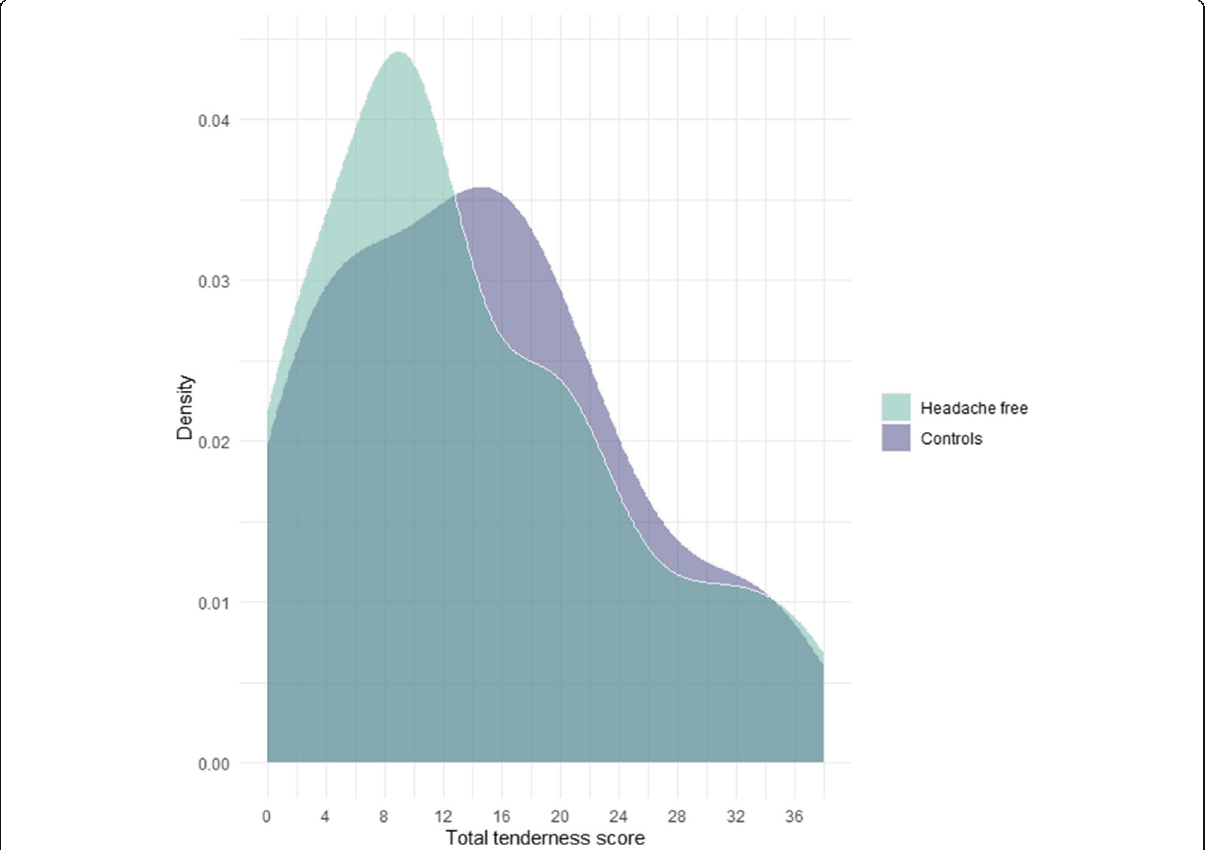
Fig. 2 Distribution of total tenderness score. Comparison of the distribution of total tenderness score in headache free participants and